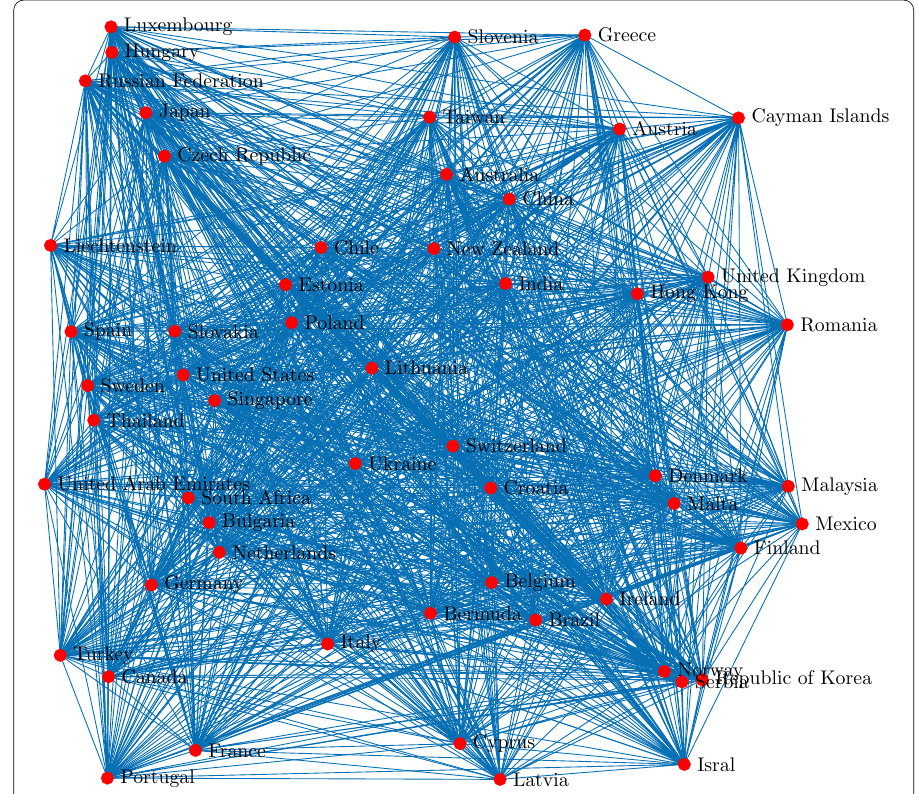
Fig. 5 Densest k-core on the meta-graph of countries ( k = 44